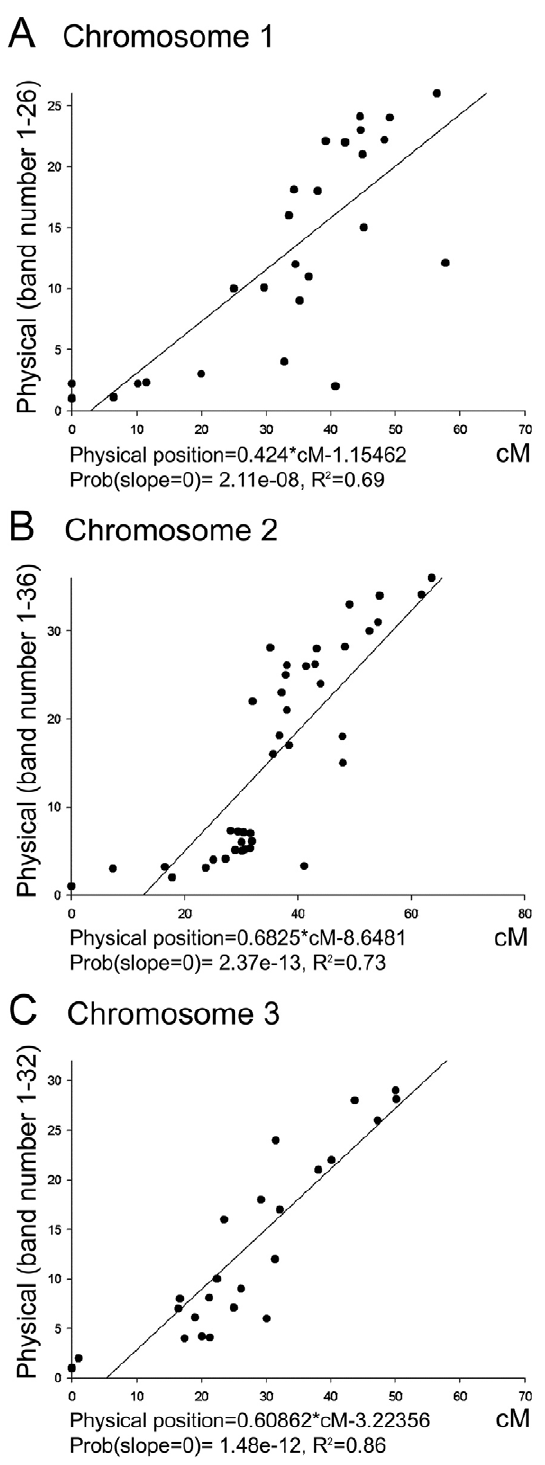
Figure 5. Linear regression analyses of the physical position of a gene as a function of its cM position. For chromosomes 1 (A), 2 (B), and 3 (C), the linear regression model is provided along with the probability that the slope is zero and the proportion of the total variance accounted for by the linear model (R 2 ).